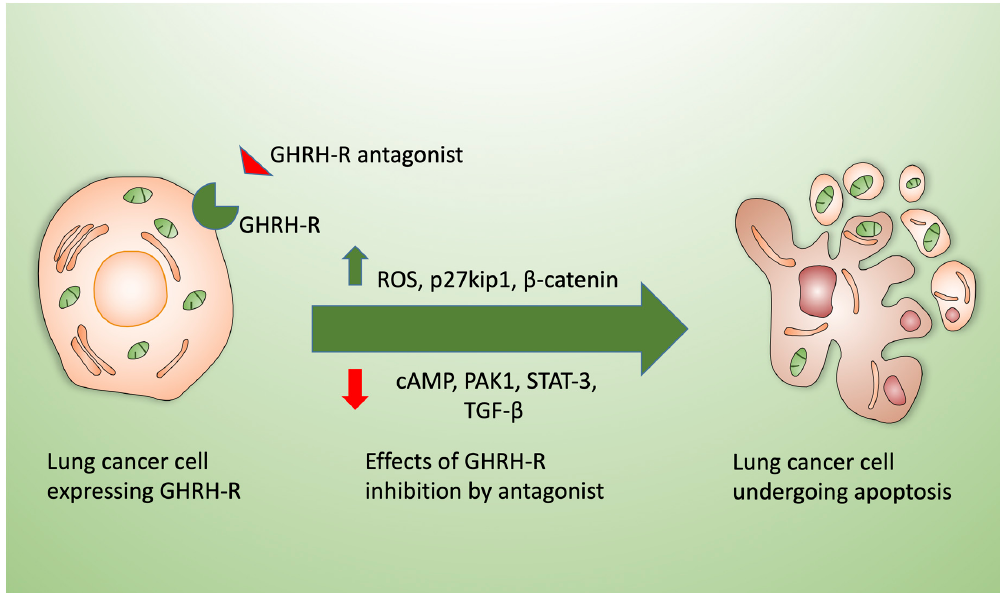
ff ects of GHRH-R antagonists (e.g., MIA-602 or MIA-690) on lung cancer cells. Exposure of Figure 3. Effects of GHRH ‐ R antagonists (e.g., MIA ‐ 602 or MIA ‐ 690) on lung cancer cells. Exposure Figure 3. E lung cancer cells in culture (left) to GHRH-R antagonists leads to cell death by apoptosis (right).